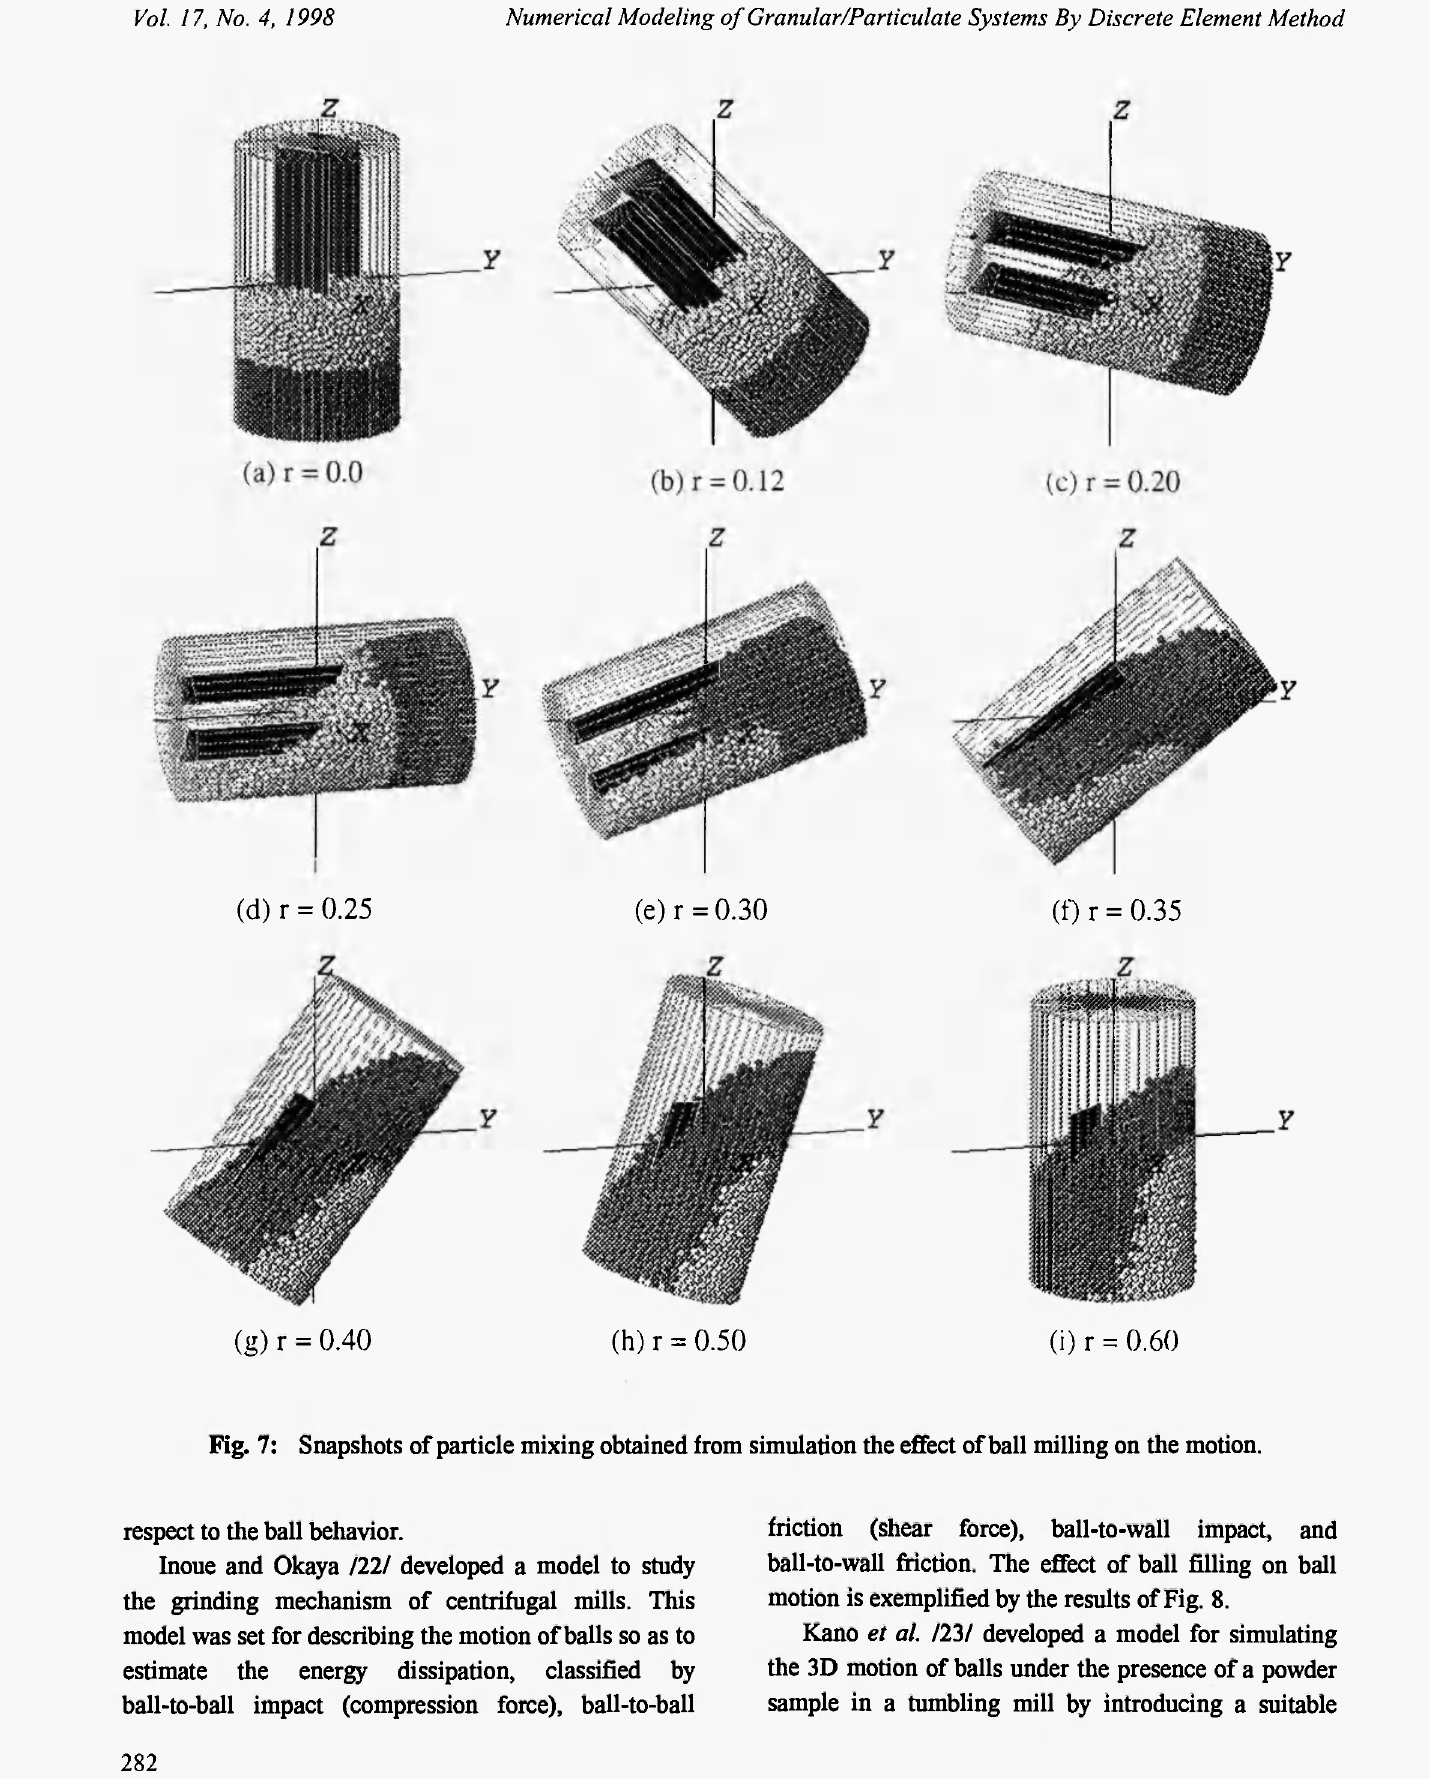
Fig. 7: Snapshots of particle mixing obtained from simulation the effect of ball milling on the motion. respect to the ball